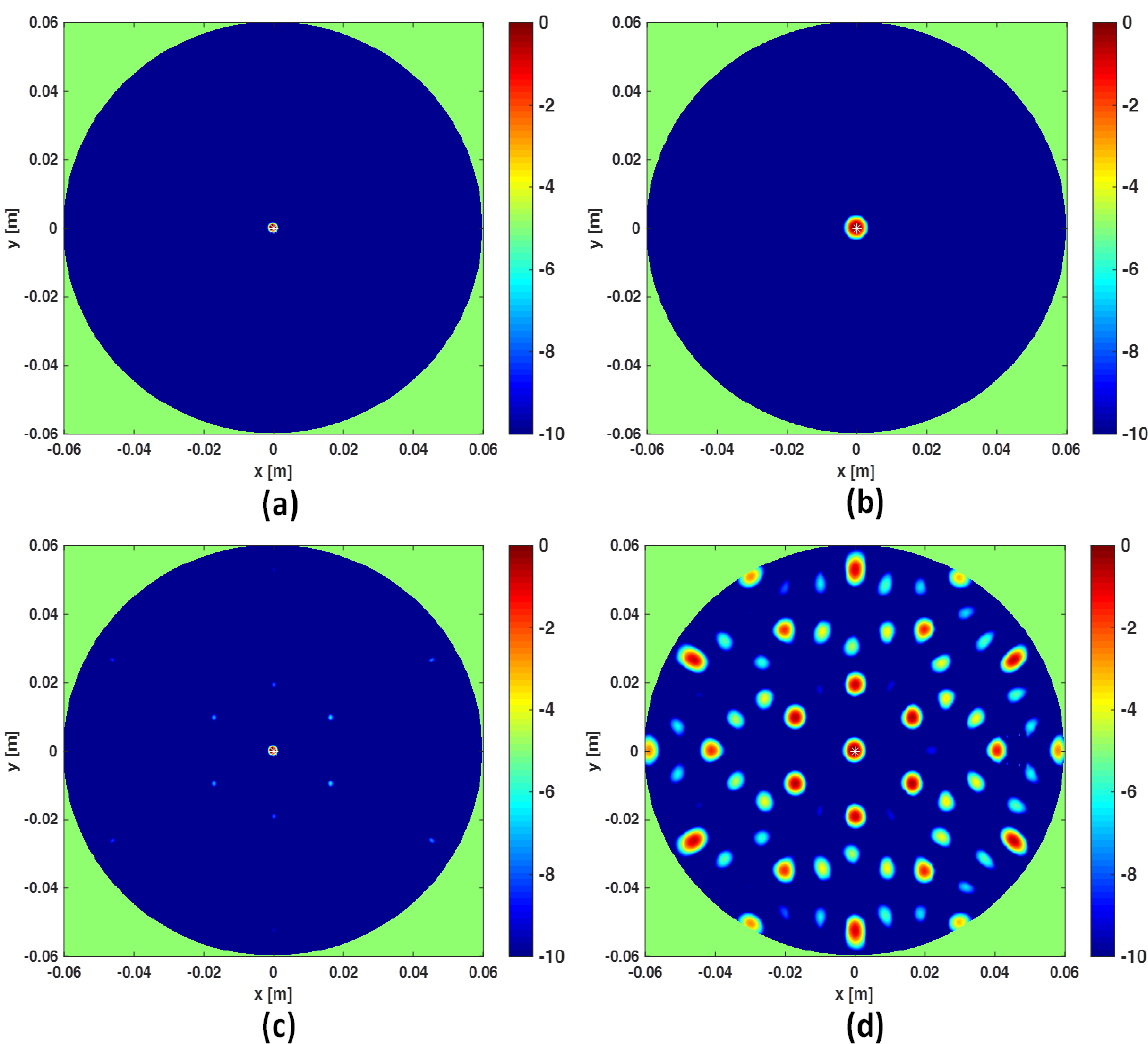
Figure 2. Comparing I-MUSIC and beam-forming (BF) for single frequency data. The left column refers to I-MUSIC; the right one to BF. In panels ( a , b ) N o = 49 whereas in panels ( c , d ) N o =